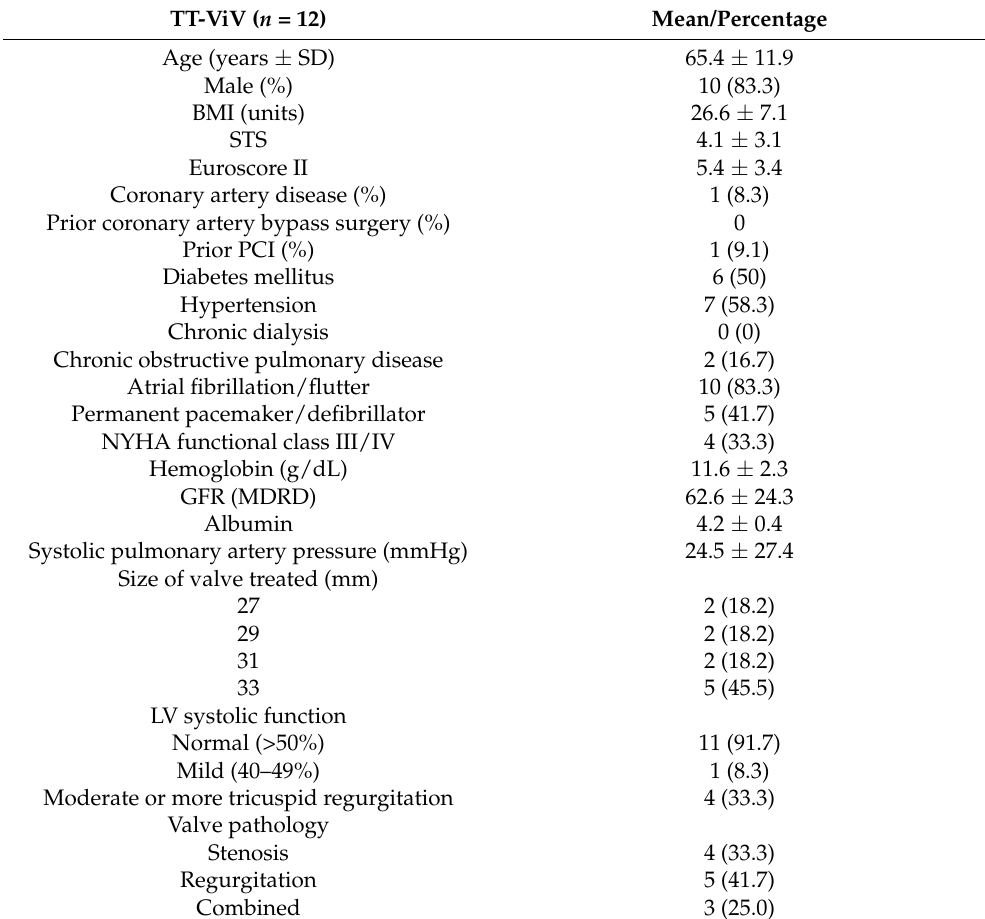
Table 1. Baseline characteristic of patients who underwent valve-in-valve implantation in the tricus- pid position.